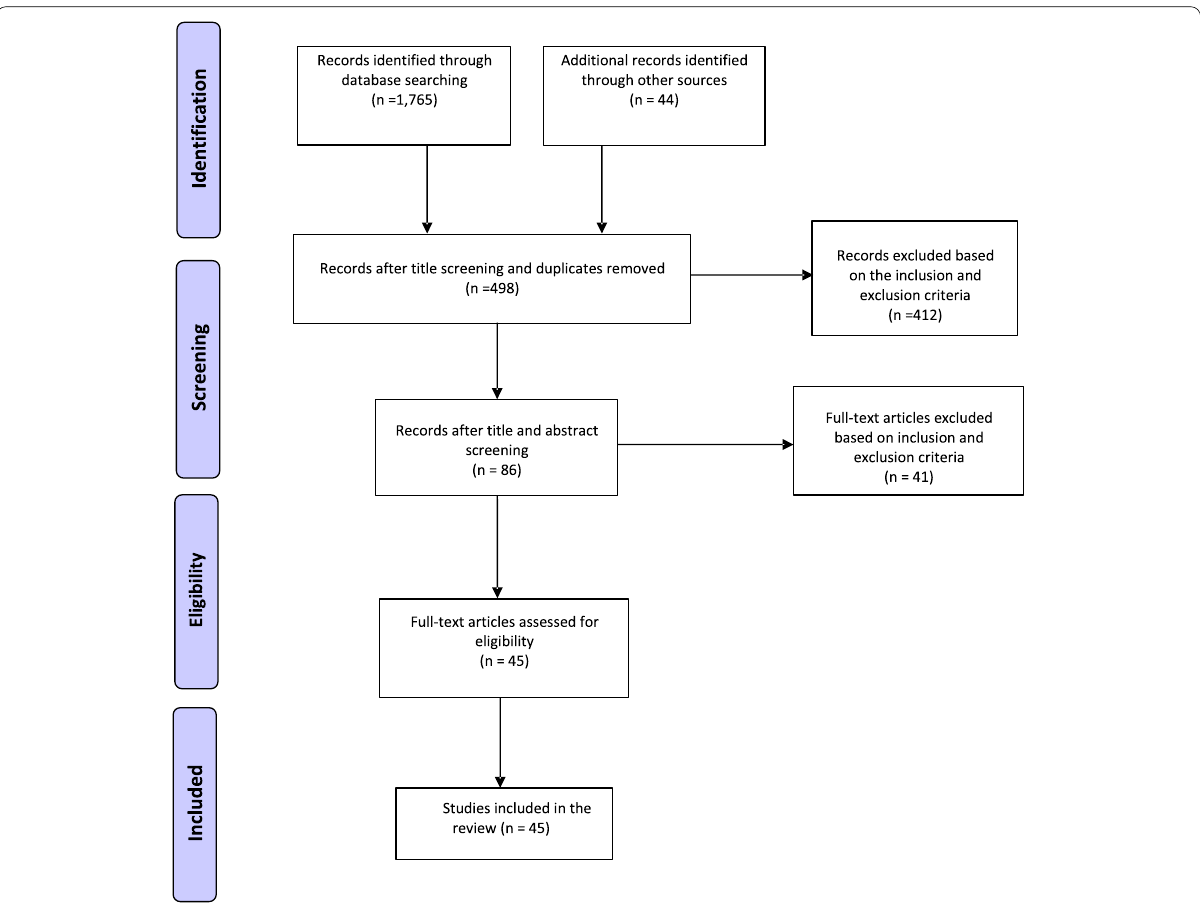
Fig. 1 PRISMA flow diagram for article